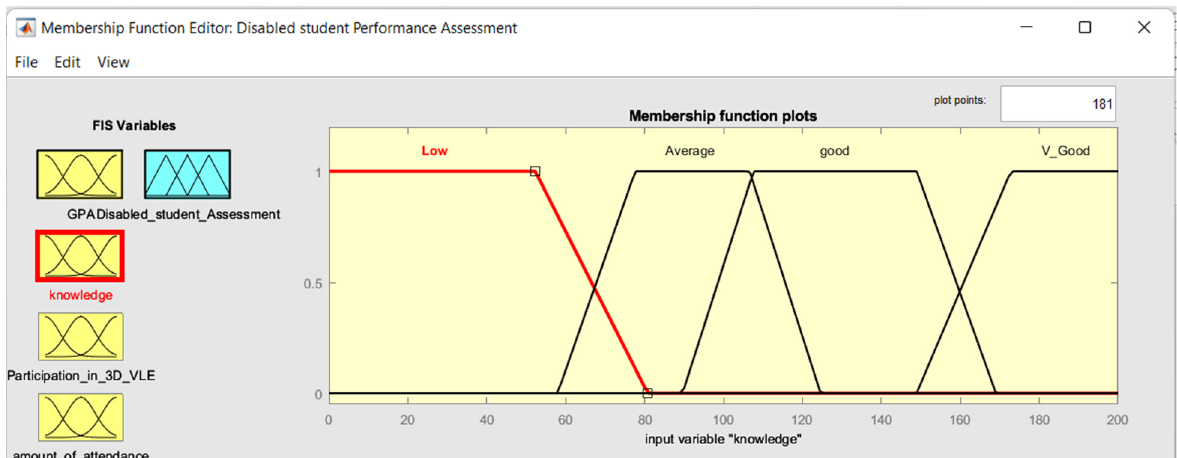
Figure 6. Input Variable knowledge.